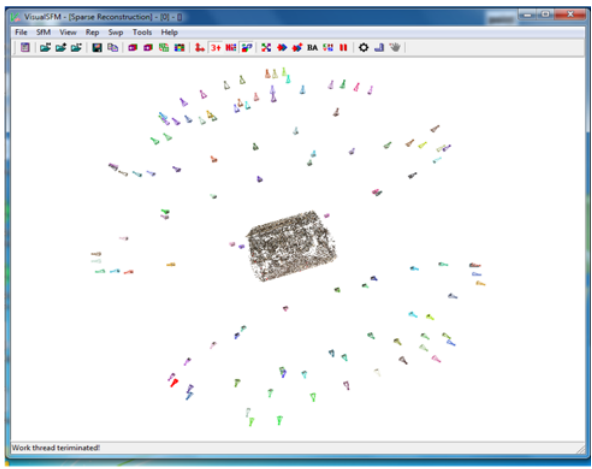
Figure 4. Screen-shot from VisualSFM, showing the camera poses relative to the object for all the